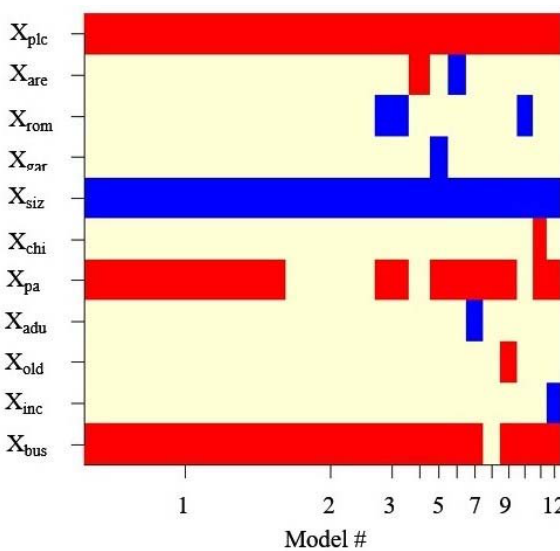
Fig. 3: Predictors chosen for the most reliable models by